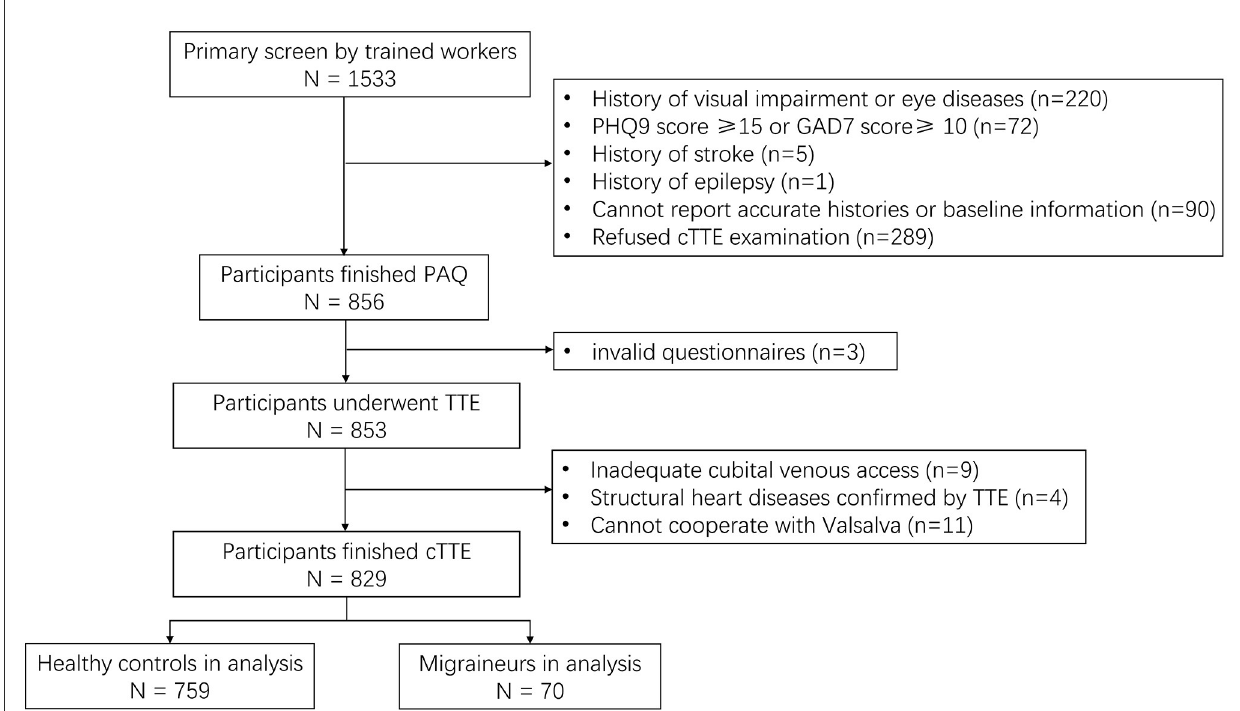
FIGURE1 Flowchart of patient recruitment. TTE, transthoracic echocardiography; cTTE, contrast medium transthoracic echocardiography; PAQ, Photosensitivity Assessment Questionnaire; PHQ, Patient Health Questionnaire; GAD, General Anxiety